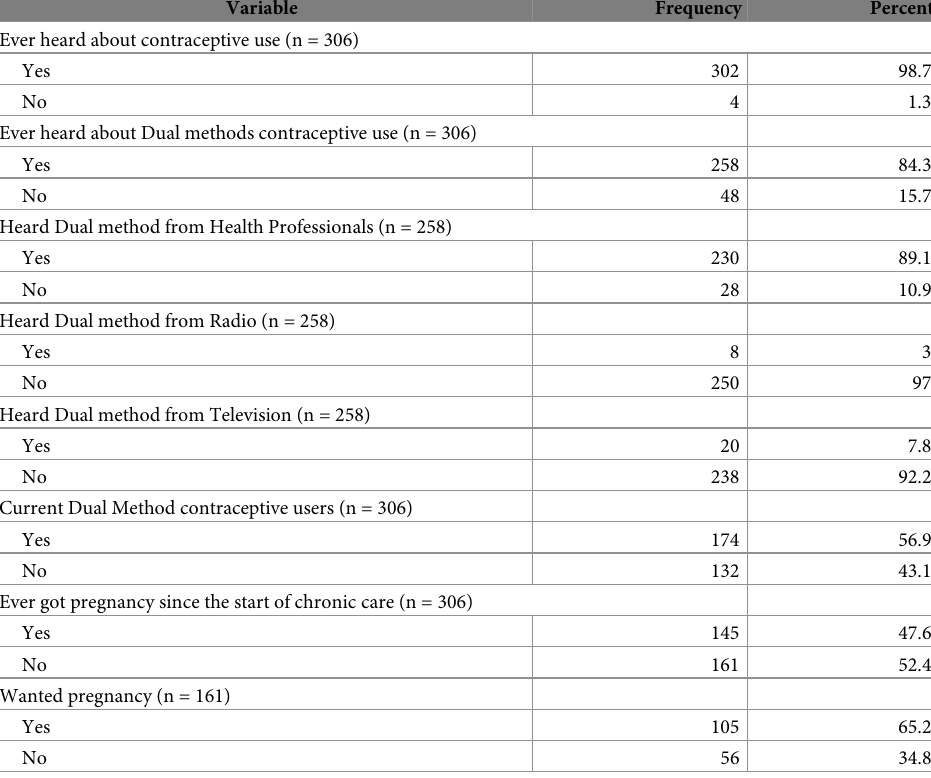
Table 2. Awareness and utilization of dual method contraceptive among HIV positive women attending chronic care follow up in Bishoftu Town Health institution, 2020. Variable